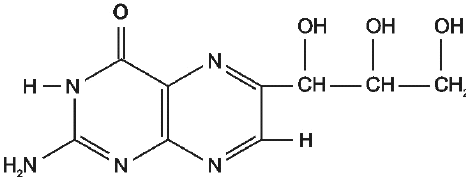
Figure 1: Neopterin (6-D-erythro-trihydroxypropyl-